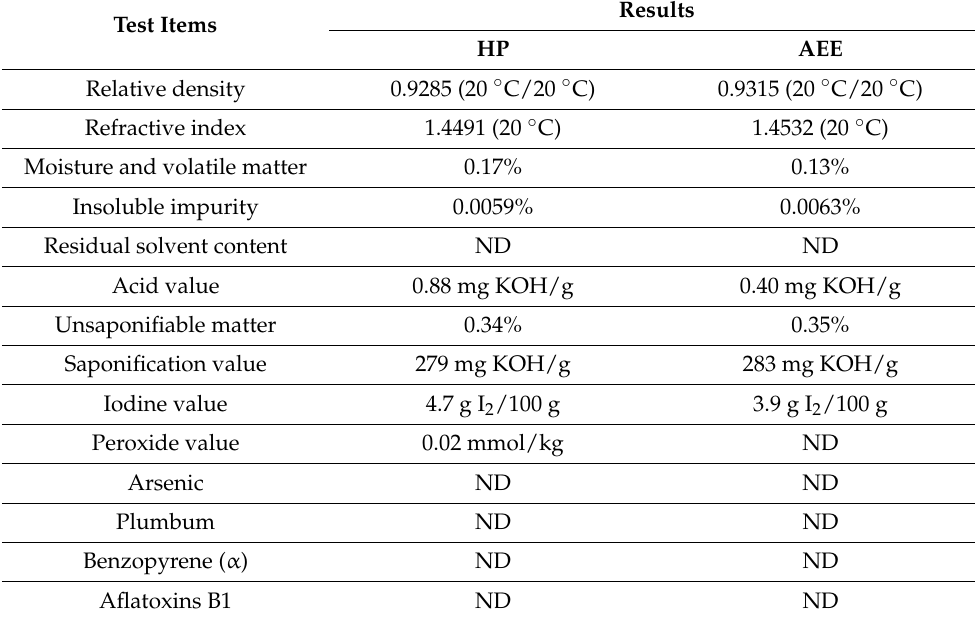
Table 3. Physicochemical properties of CCSKO.